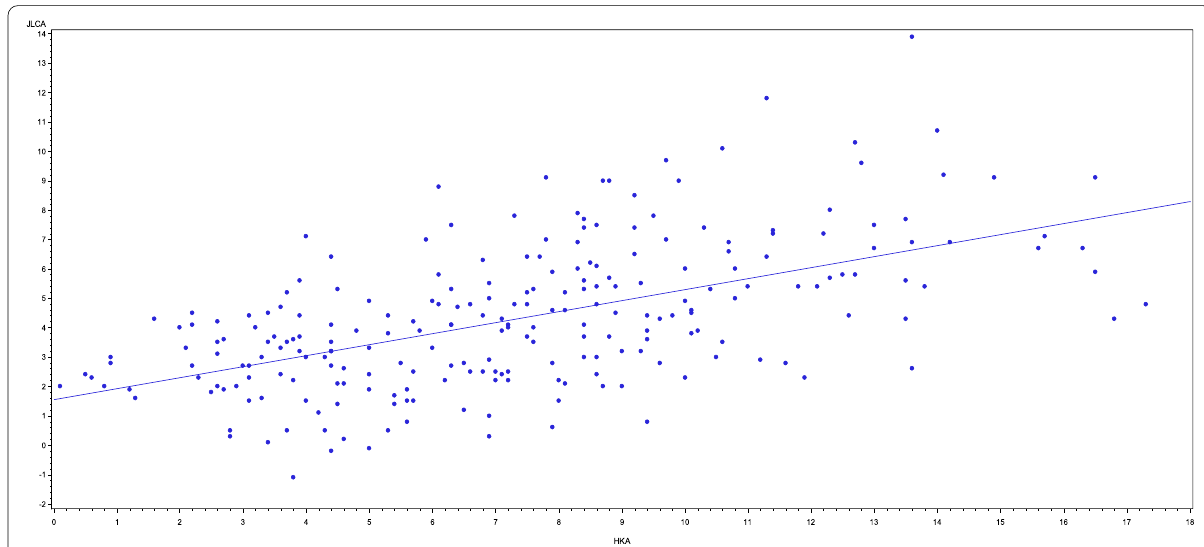
Fig. 2 In this graph, the HKA angle is seen on the x-axis. Plotted against it on the Y-axis is the JLCA, also measured in degrees. A positive linear correlation is observed. The p -value for this correlation is